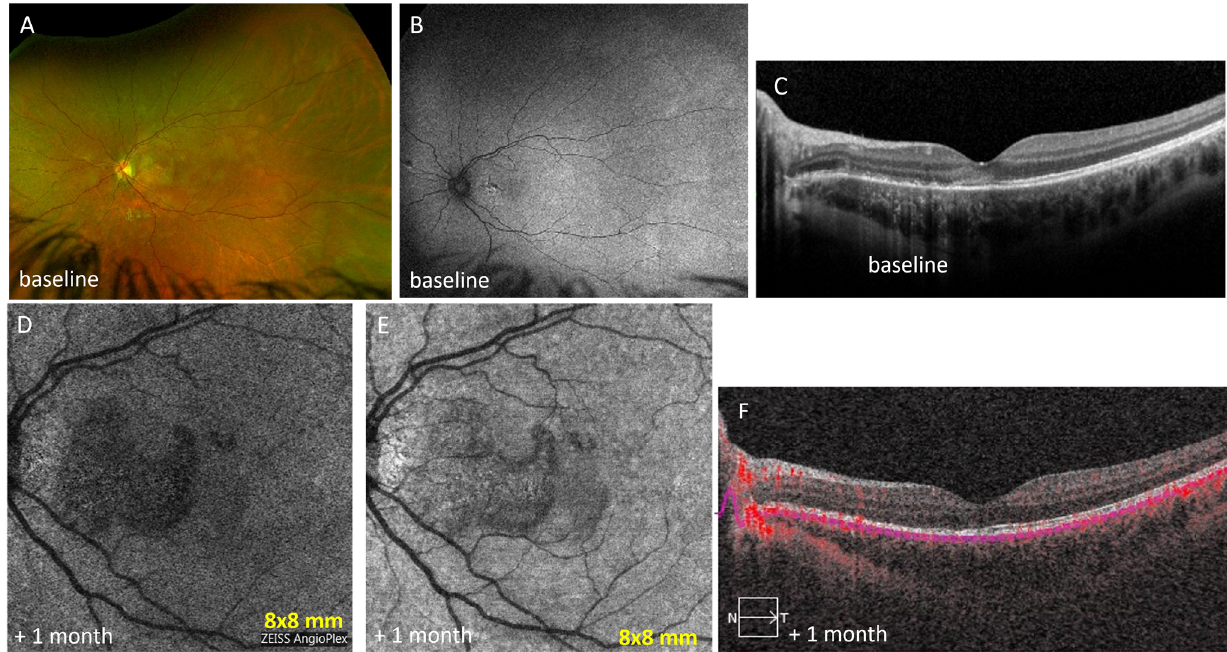
Figure 5. Case 5: APMPPE. ( A ) Wide-field fundus photo of the left eye showing deep placoid subretinal lesions between optic nerve and fovea and retinal pigment epithelial pigment changes at the fovea. ( B ) Wide-field fundus autofluorescence picture of left eye showing a hypoautofluorescent lesion with a hyperfluorescent margin at the center of the left eye and one lesion supero-nasally in the left eye. ( C ) SD-OCT (Heidelberg Spectralis) showed outer retinal reflectivity with ellipsoid zone disruption at the macula of the left eye. There are also corresponding hyperreflective lesions in the choriocapillaris. ( D ) Zeiss PLEX ® Elite 9000, OCTA (9 mm × 9 mm) at the level of choriocapillaris after one month was significant for non-detectable flow signal at the macula. ( E ) The corresponding structure shows that there is a shadow corresponding to the macular lesion. ( F ) SD-OCT shows an outer retina alteration nasal from the fovea at the lesion’s location. Due to frame averaging, the OCT image provided by Spectralis Heidelberg SD-OCT (image ( C )) had a better signal to noise ratio than the OCT provided by the SS-OCT Zeiss PLEX ® Elite 9000 at follow-up (image ( F )).